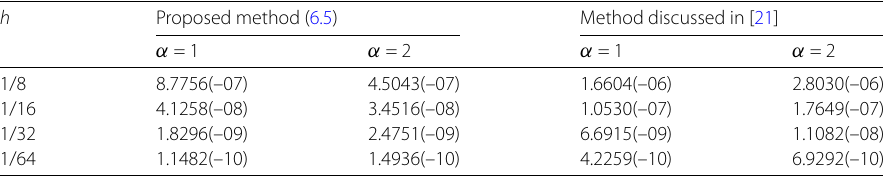
Table 3 Problem 8.3: The maximum absolute errors h